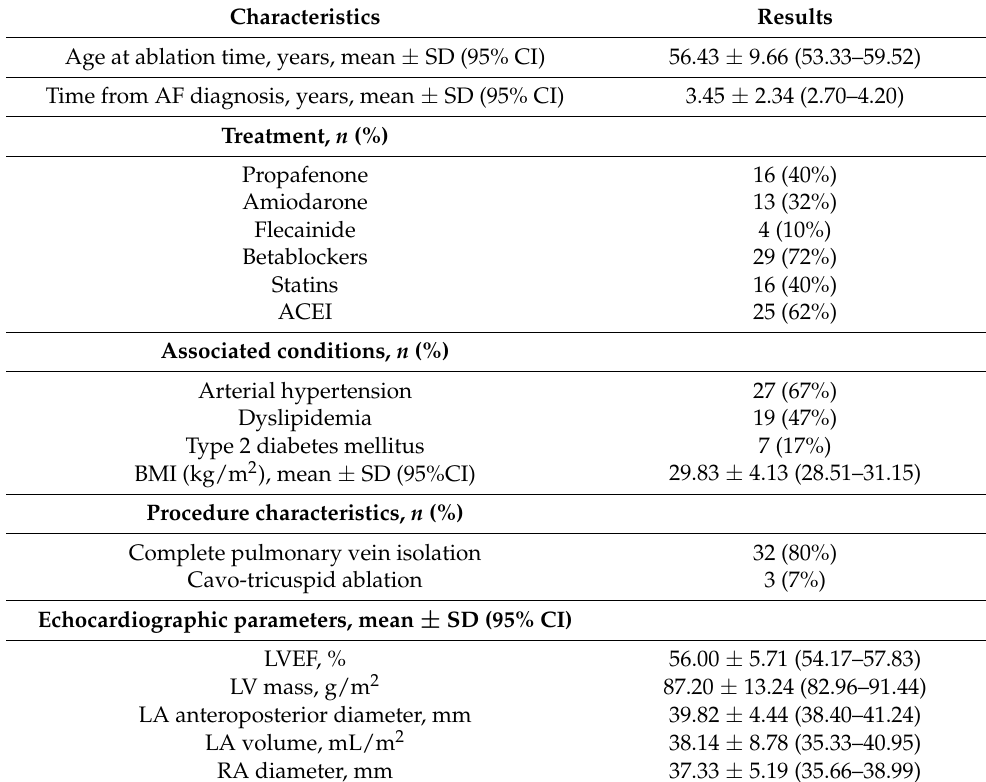
Table 1. Baseline characteristics of patients ( n = 40).